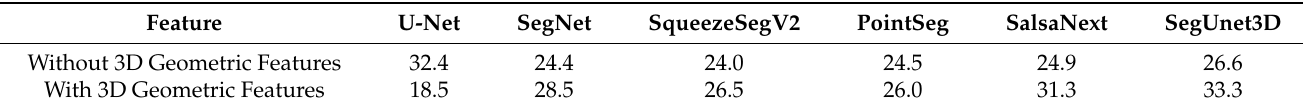
Table 6. The results of usage of 3D geometric features on RELLIS-3D. The values are in %.